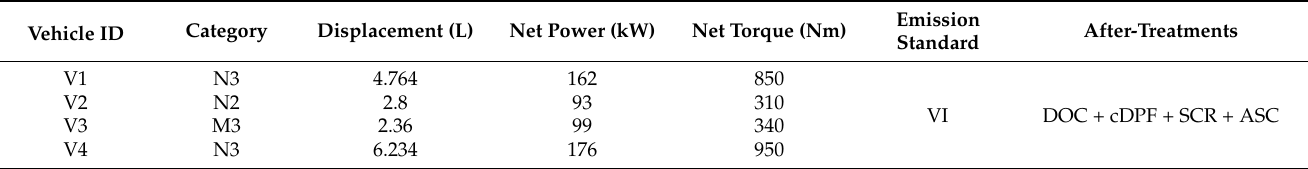
Table 1. Test vehicles and emission control devices.